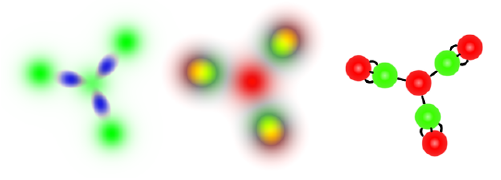
Figure 8 : ( Q 1 ; Q 2 ) = (4 ; 3) minimal vortex \extended (cid:13)ower", which is the minimum- energy local vortex in its charge sector. The (cid:12)gure contains 3 elements from left to right: an energy density plot, a (cid:12)eld density plot and a sketch of how the red and green vortices are interconnected. The (cid:12)rst two plots are made using the coloring scheme of (cid:12)gure 2. call this type, the vortex \pill", which is nothing but the simplest vortex \(cid:13)ower" with only two petals or the simplest vortex